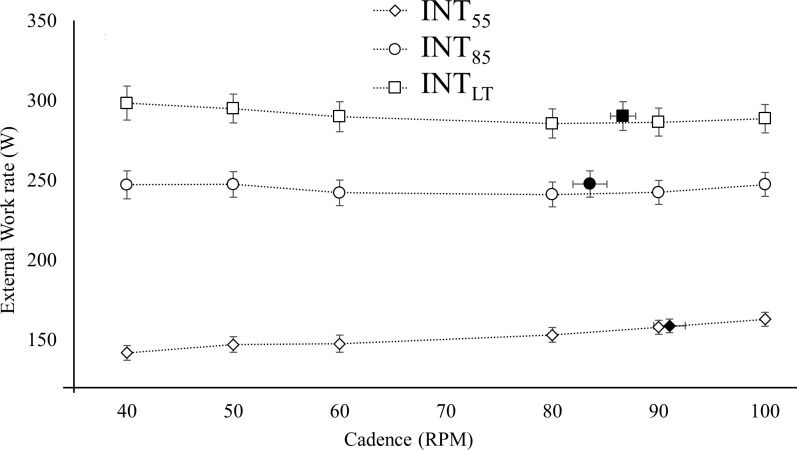
External power against cadence.Group mean and standard error for (A) external power at Int55 (diamond), Int85 (circle) and IntLT (square) at all cadences (filled marker indicate FCC).